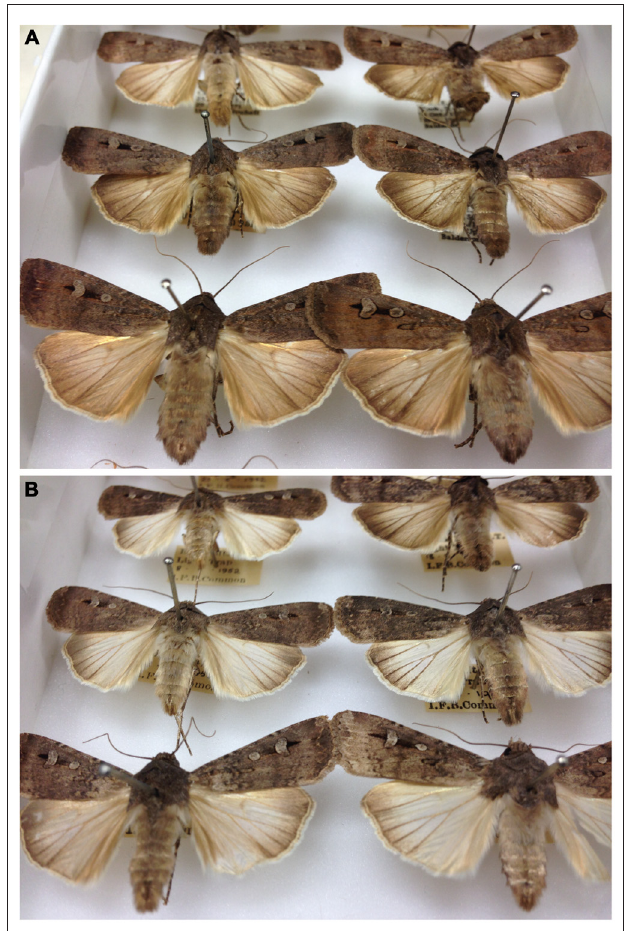
FIGURE 7 | Migratory (A) and non-migratory (B) morphs of the Bogong moth. Note the paler hindwings of the non-migratory morph. Photographs taken in the Australian National Insect Collection, Canberra (Photos: Eric